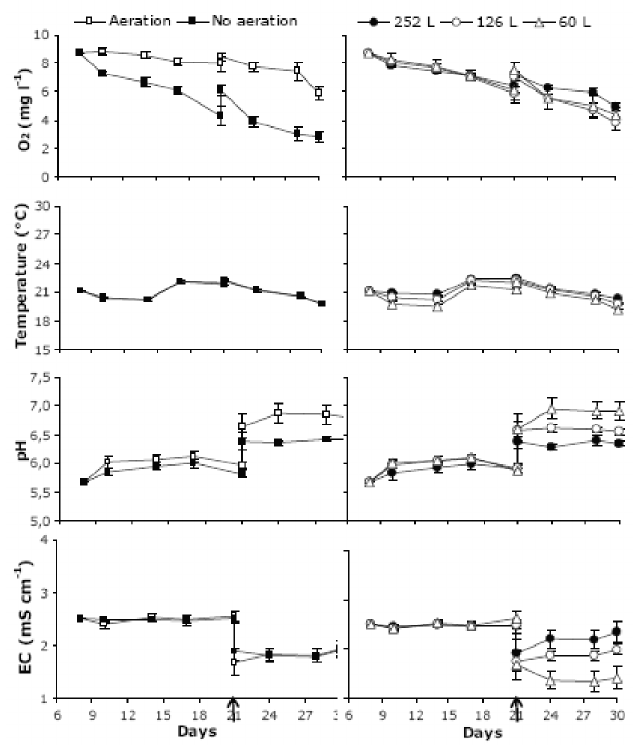
Fig. 2 - Effect of aeration (left) and volume (l per m 2 of cultivated area) (right) of the nutrient solution on its O 2 concentration, temper- ature, pH and EC during the autumn cultivation cycle of spinach. Error bars (± SE ) are shown when larger than symbols. Arrows indicate the date when the consumed solution was restored with tap water.